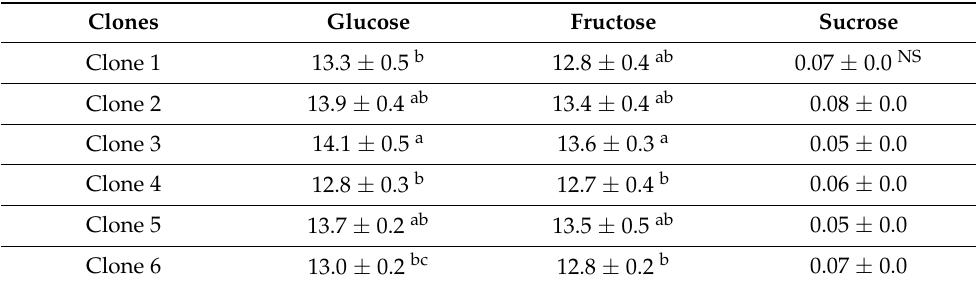
Table 6. Sugar content (g/100 g FW) in juices of six ‘Köhnü’ clones.